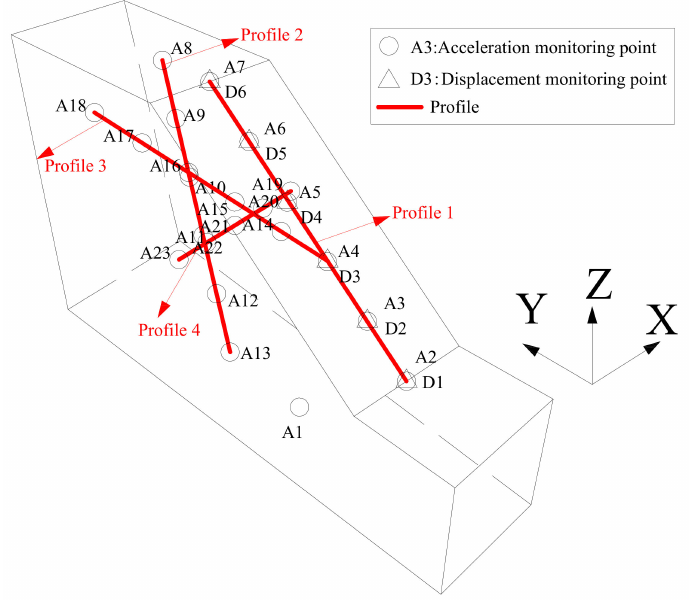
Figure 6. Spatial locations of the acceleration (A) and displacement (D) monitoring points and the profiles upon which they are located in the slope